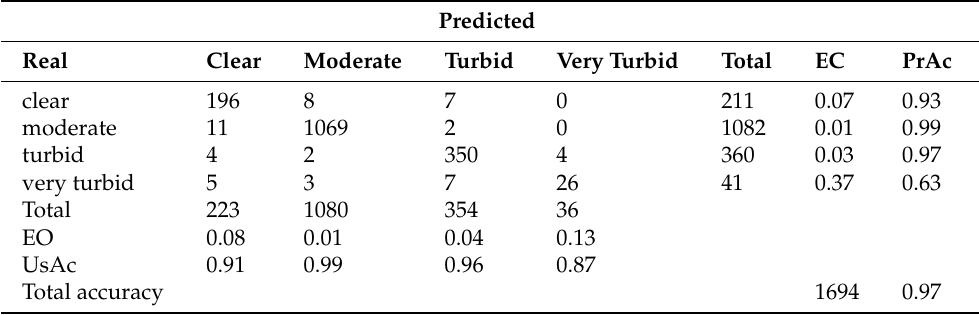
Table A1. Confusion matrix KNN with all bands. EC is error of commission; EO is error of omission; PrAc is the producer’s accuracy; UsAc is the user’s